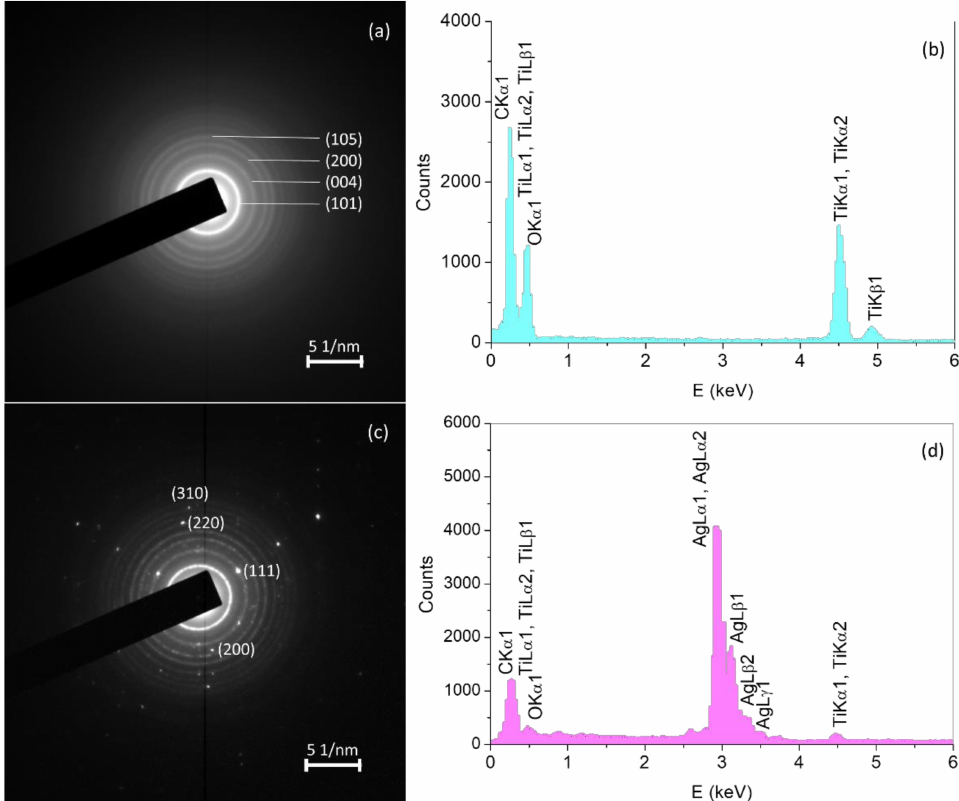
Figure 5. ( a ) Selected area electron diffraction (SAED) pattern and ( b ) energy dispersive X-ray spectroscopy (EDS) spectra of fine light grains area; ( c ) SAED and ( d ) EDS of big dark grain area in Figure 4.